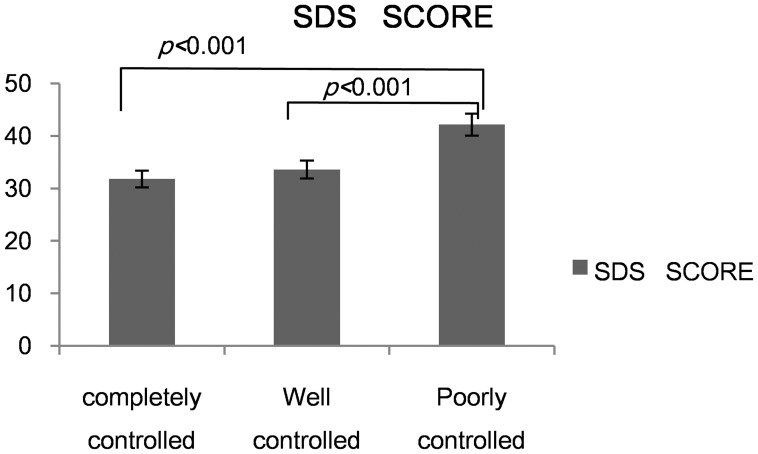
Depression score across different asthma groups.